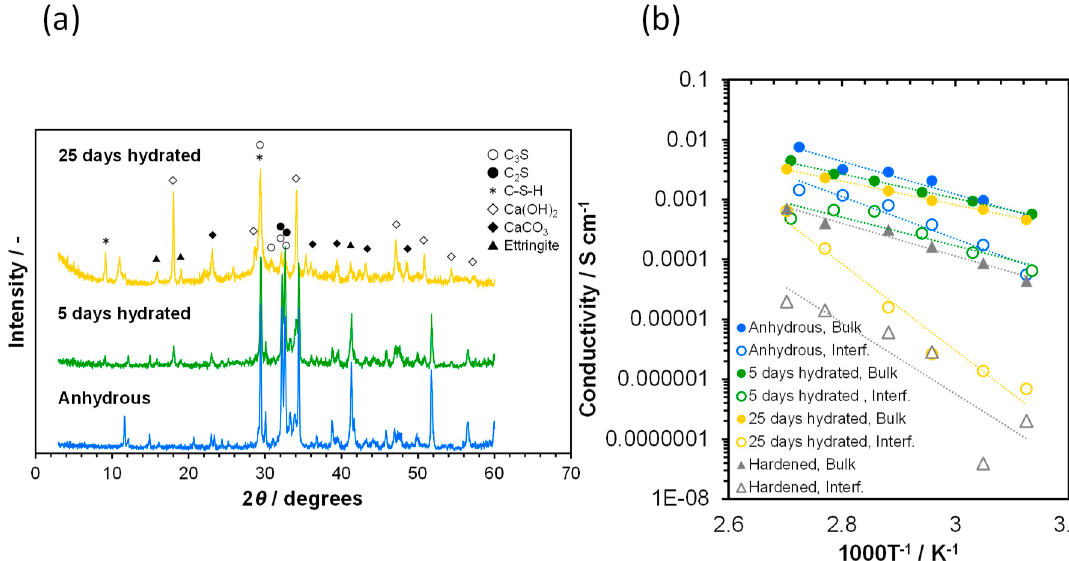
Figure 2. Characterization of the cement samples with di ff erent degrees of hydration. ( a ) XRD patterns. ( b ) Temperature dependence of the bulk and interfacial